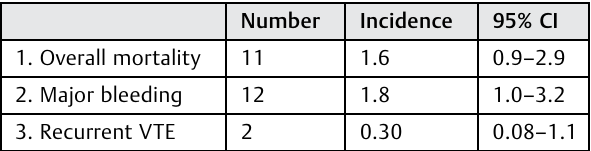
Table 2 VTE-related adverse events of patients treated